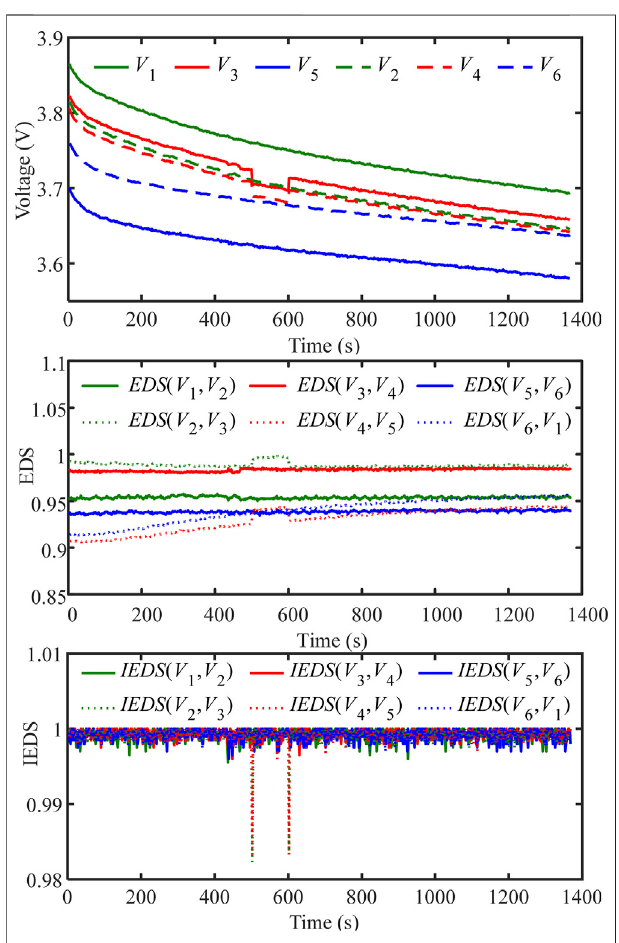
FIGURE 5 | Evaluation results of EDS and IEDS under the normal condition.